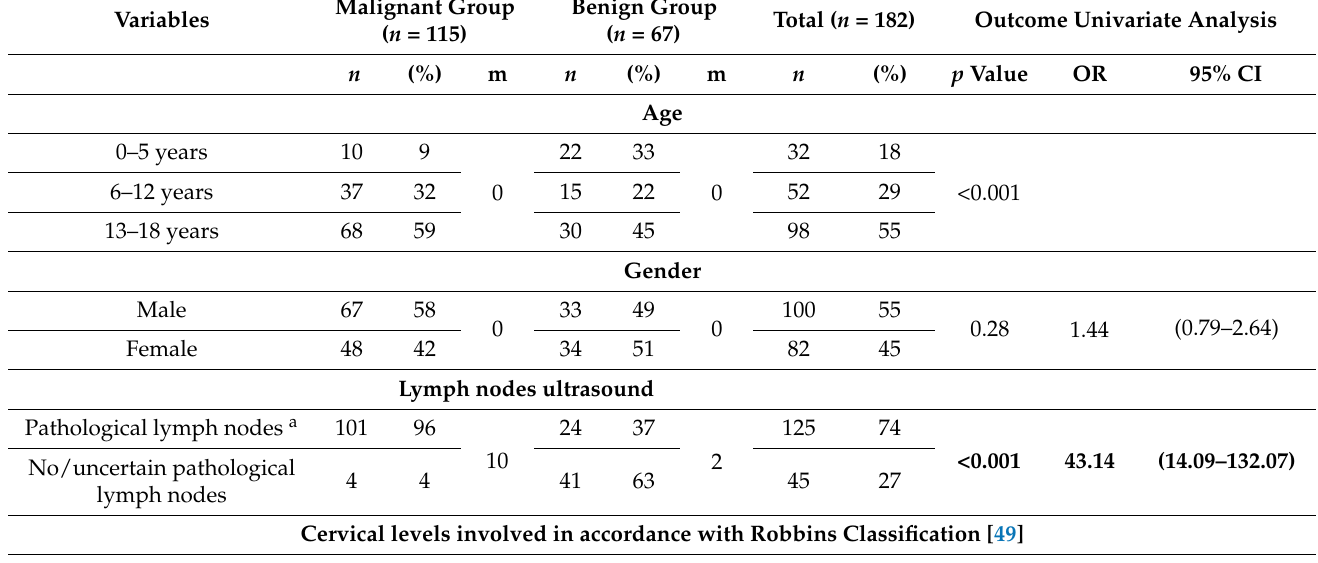
Table 2. Univariate analysis of all variables analyzed as prediction factors for